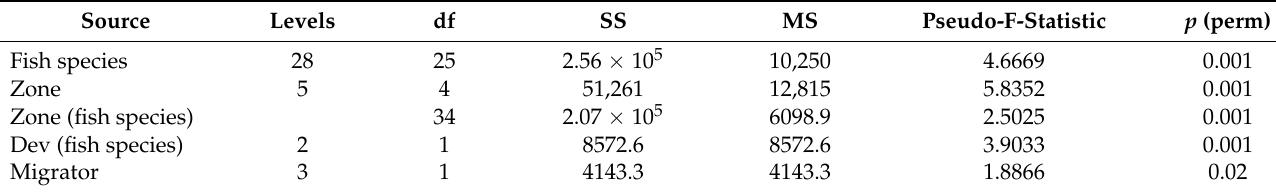
Table 2. PERMANOVA analysis via the sum of squares Type III, with unrestricted permutations (999) of raw data. Dev: developmental stage; Migrator: migratory pattern; df: degrees of freedom; SS: mean of the sum of squares; MS: mean squares; and perm: permutations. Zone and Dev are nested in fish species.